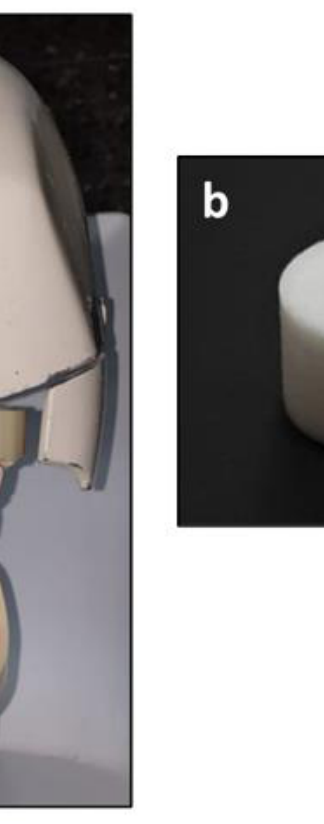
Figure 1. The mannequin setup. ( a ) The transducer is located at the molar area of the lower right quadrant. ( b ) the mold for preparing the specimens.